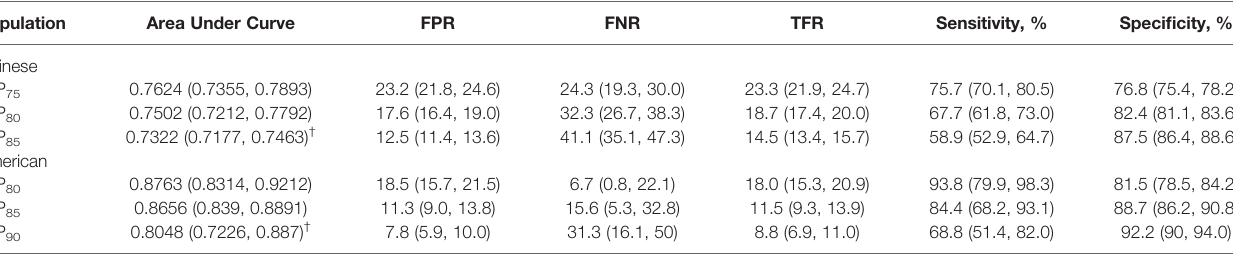
TABLE 2 | Validation of selected cut-off percentile of Tri-ponderal mass index in identifying cardiometabolic risks in Chinese and American validate populations. Population Area Under